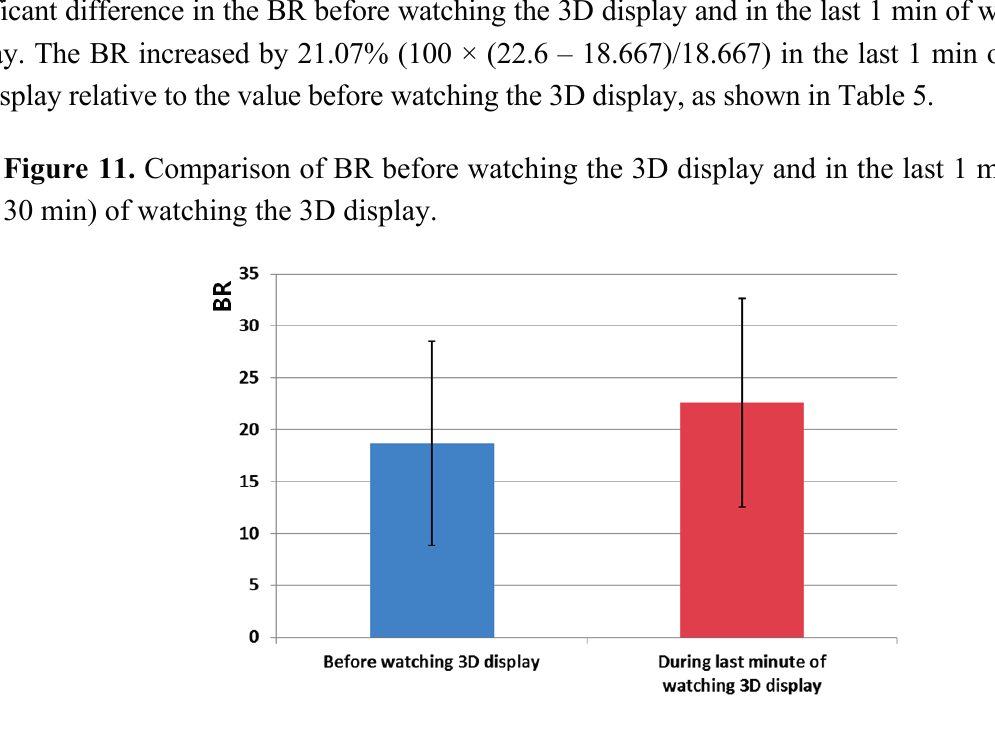
Table 5. The average and standard deviation of the eye